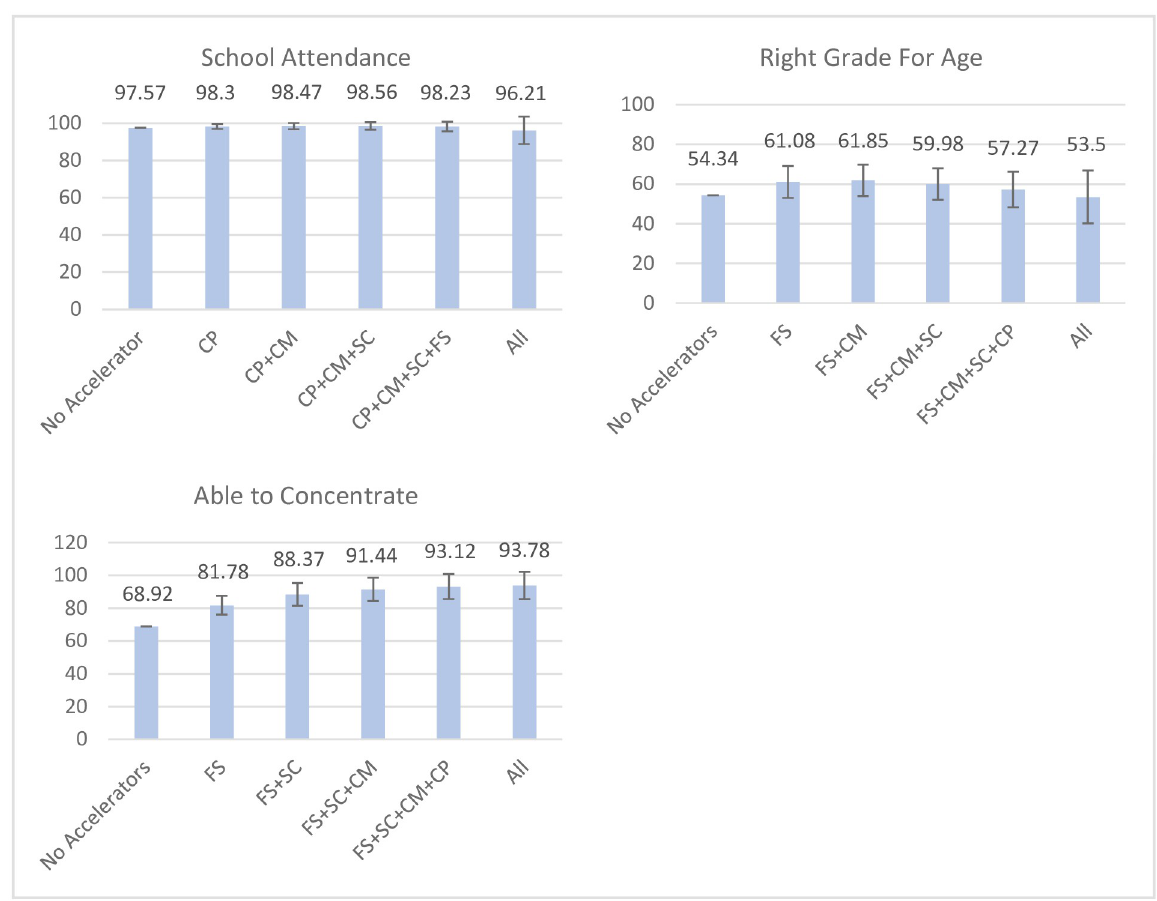
Fig 3. Accelerator combinations leading to the strongest changes in adjusted probabilities for each school outcome. Figure scales adjusted based on range of outcome values. CBO = Access to community-based organisations, SC = Living in a Safe Community, CP = Caregiver Praise, FS = Food security, CM = Caregiver Monitoring. 95% confidence intervals